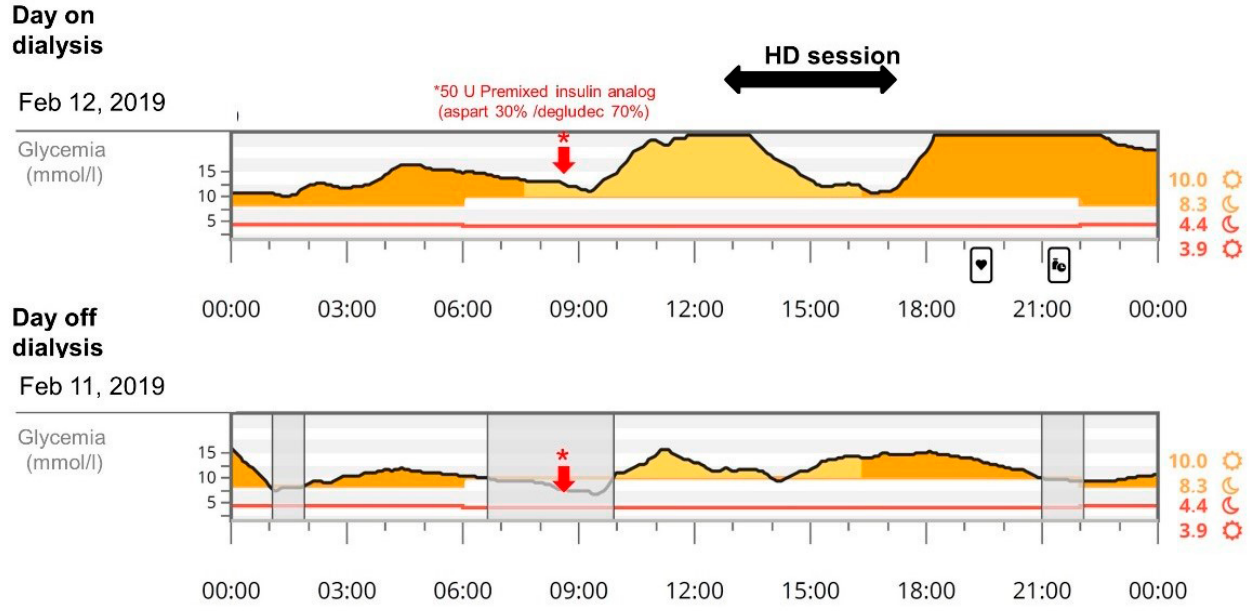
Figure 2. Intra and post-dialytic glycemic variability detected by the CGM (Dexcom G6) in a 82 year old insulin-treated type 2 diabetic patient: Major pre-dialytic hyperglycemia causing pronounced glycemia decrease during dialysis session followed by post-dialytic reactive hyperglycemia. On the other hand, the glycemic profile was stable during the previous day without hemodialysis.